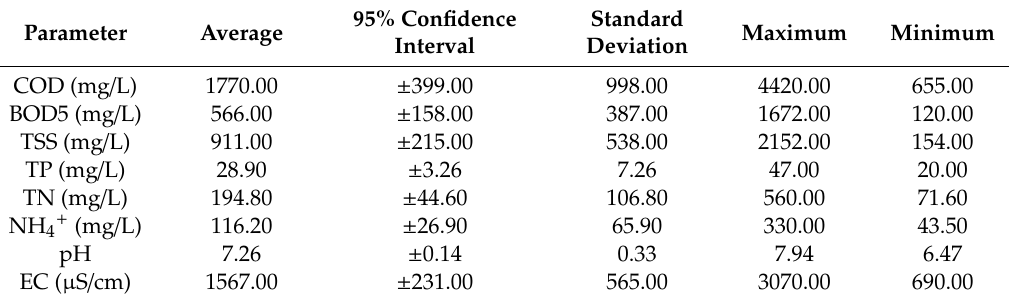
Table 2. Input load of the treatment